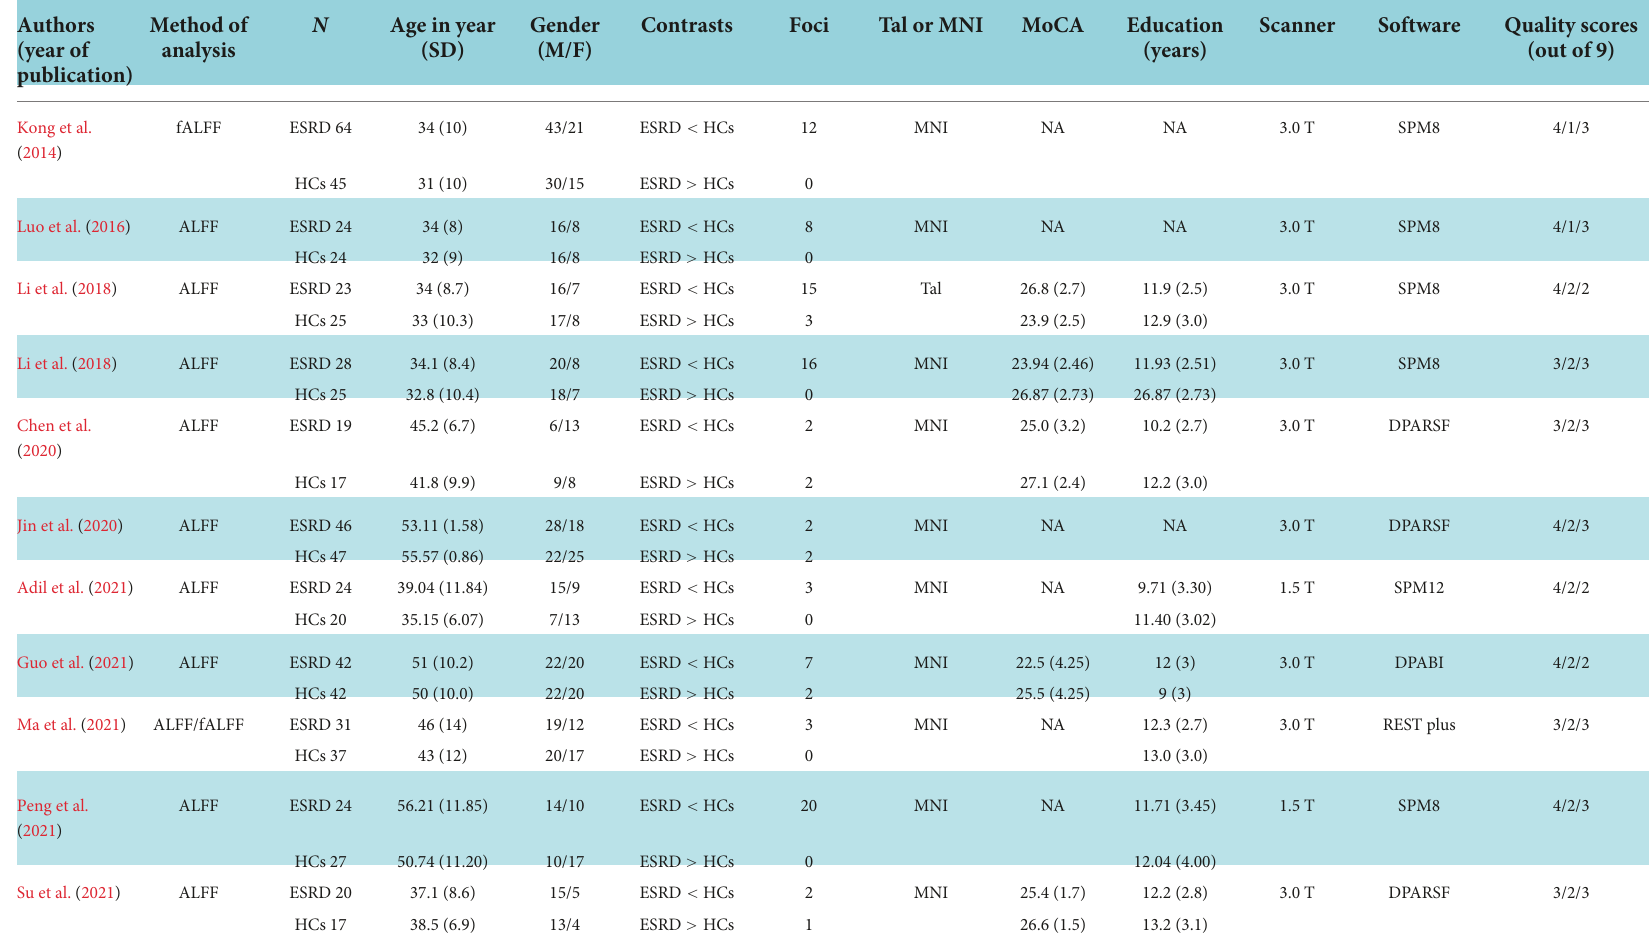
TABLE 1 Demographic and imaging characteristics and quality scores of all studies included in the